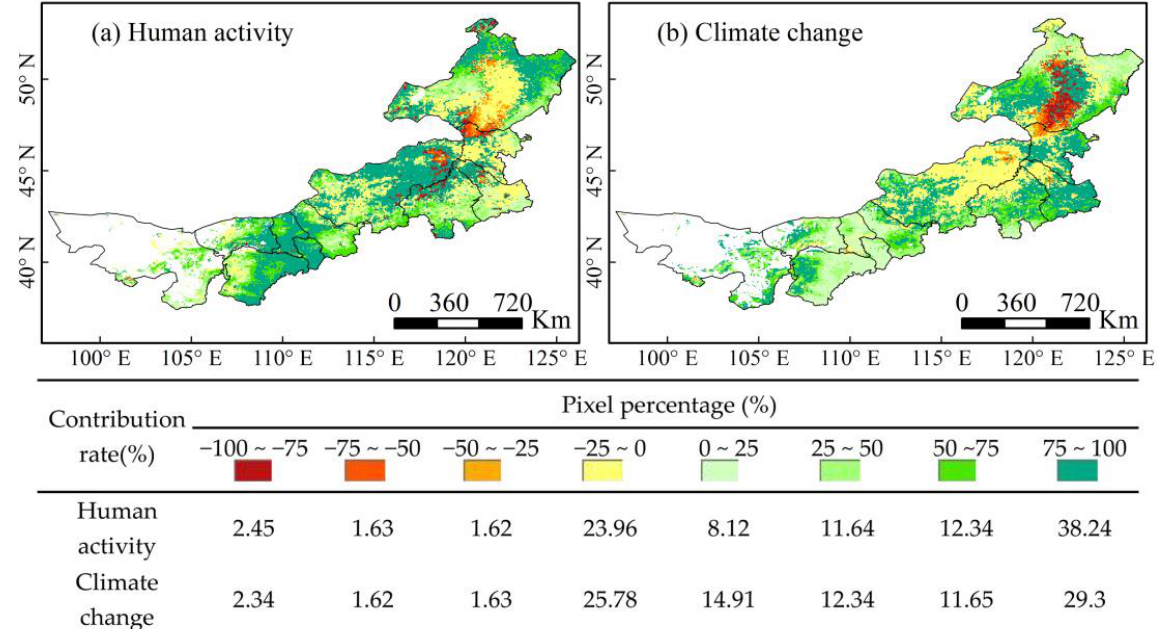
Figure 9. Spatial distribution of positive and negative contributions of human activity and climate change on variations in WUE from 2001 to 2020.